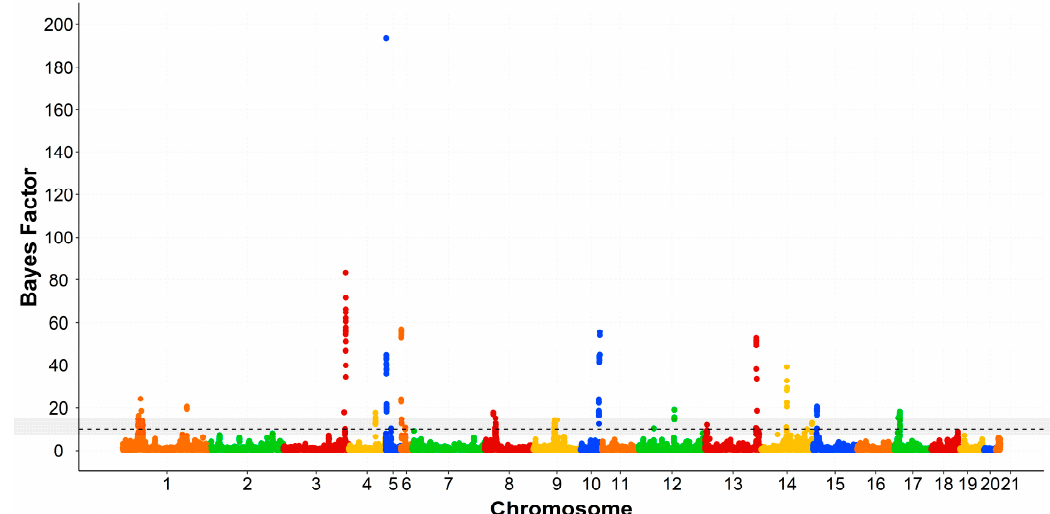
Figure 2. Manhattan plot of genome-wide association study for polyunsaturated fatty acids. The black dashed line indicates the Bayes factor threshold of 10. Each dot represents a SNP. X-axis: chromosomes. Y-axis: Bayes factor.